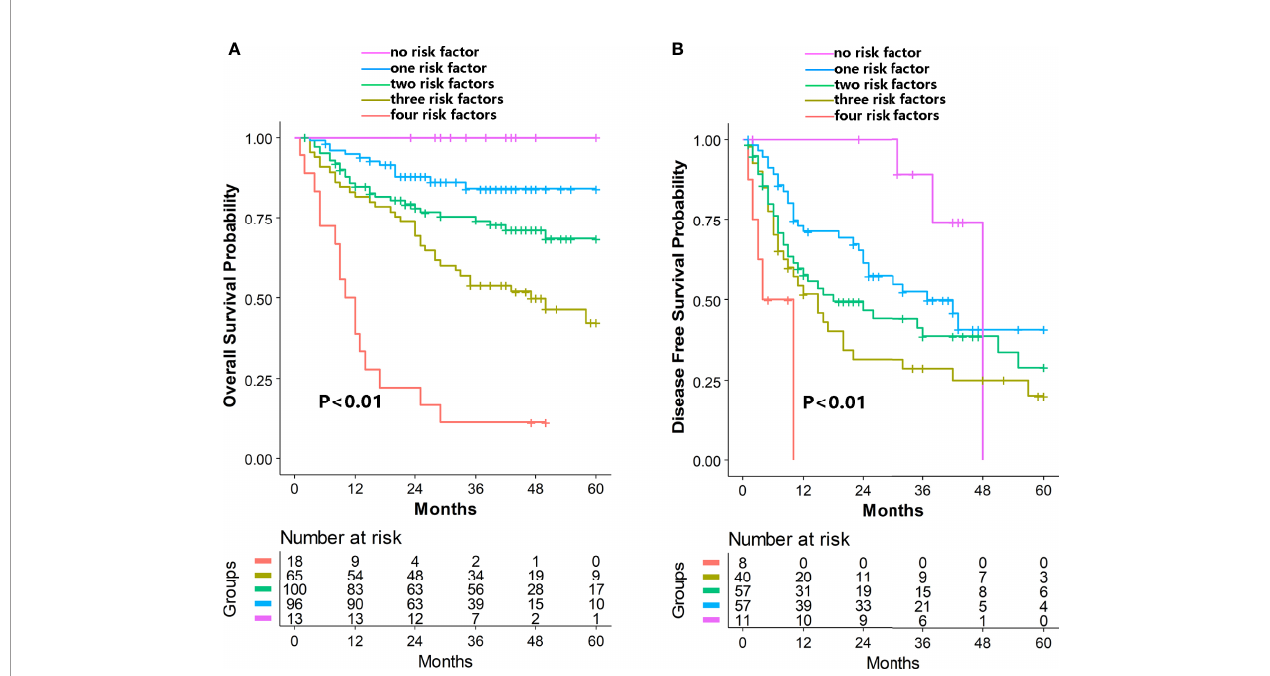
FIGURE 2 | Cumulative effects of immune-related markers on OS (A) and DFS (B) in hepatocellular carcinoma. High expression of CD66b, CD68, or OX40 and low expression of CD8 were identi fi ed as the independent risk factors. The purple, blue, green, yellow, and red lines represent the group of patients with none, one, two, three, and four risks, respectively. OS, overall survival; DFS, disease-free survival.